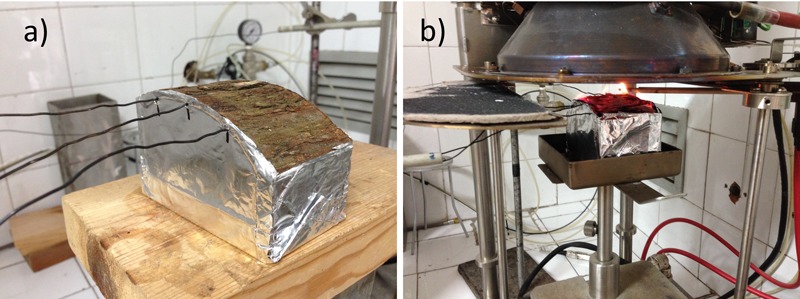
Flammability tests of bark of the four species considered were performed by MLC on 10 cm × 10 cm × 10 cm disk portions (b). Temperature reached at the bark surface and in the cambium were measured with thermocouples (a).